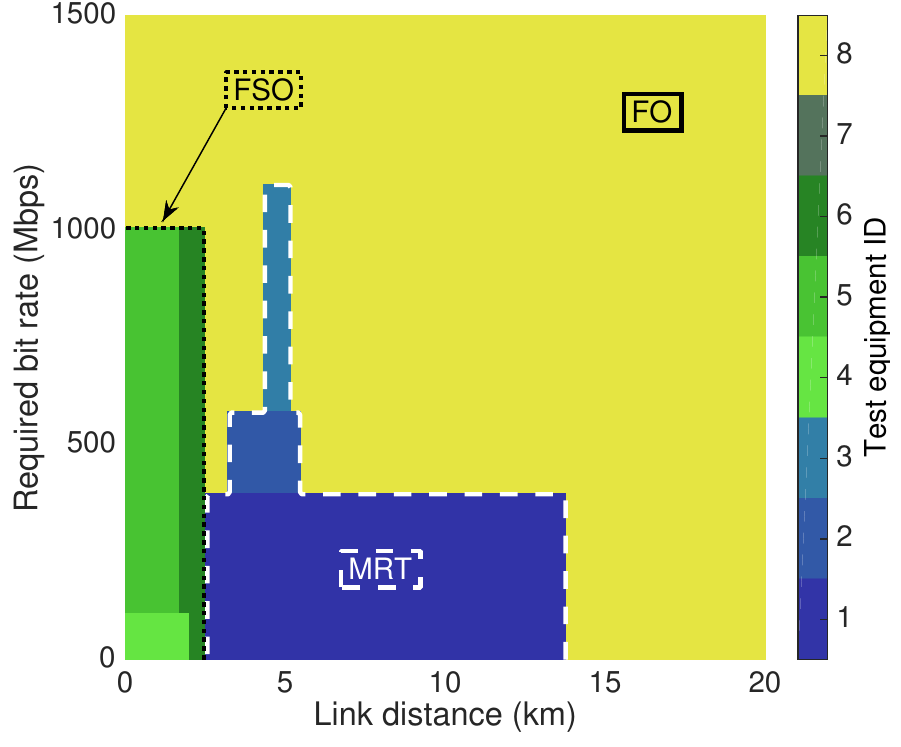
Figure 5. Cost-effective solutions for S(r_h/f_l).